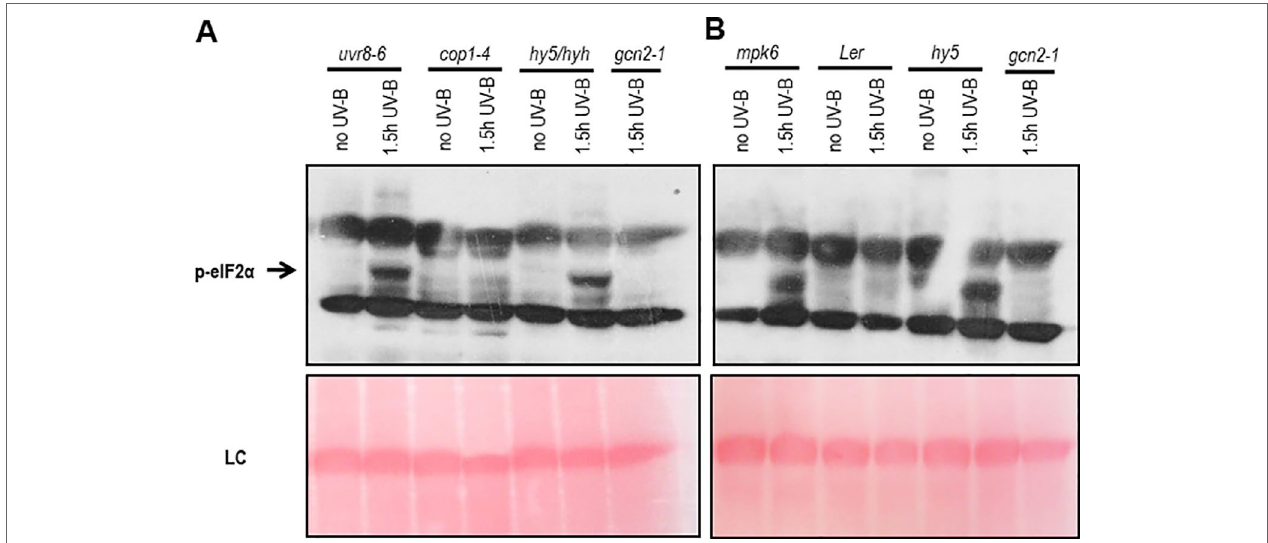
FIGURe 2 | Western blots assaying activation of GCN2 via eIF2α phosphorylation in UV-B specific and stress signaling mutants. (A) Mutants of the UV-B photoreceptor specific signaling pathway and gcn2-1 were harvested after 1.5 h of 6 µmol m -2 s -1 broad band UV-B treatment. (B) Wildtype and mutants of the stress and UV-B signaling pathway after 1.5 h of broad UV-B with 10 µmol m -2 s -1 . Equal amount of protein (20 μ g) was loaded on 10% sodium dodecyl sulfate polyacrylamide gel electrophoresis. LC, Loading control.